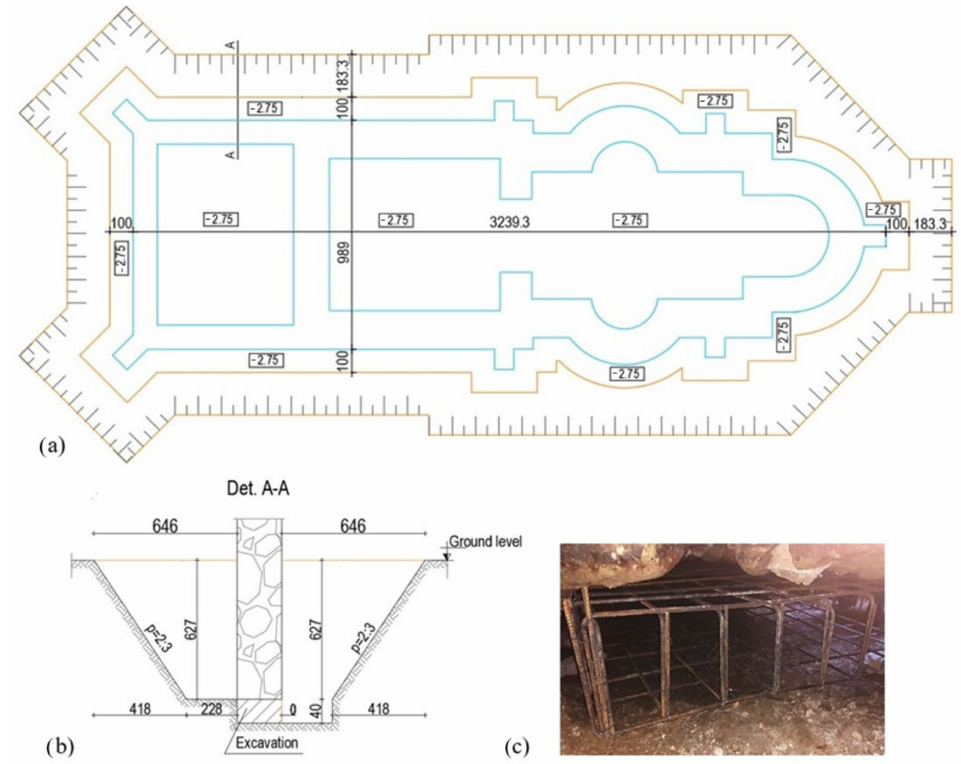
Figure 11. Reinforced concrete pads ( a ) Excavation plan, ( b ) Detail A-A, ( c ) Reinforcement of the pads (dimensions in cm).